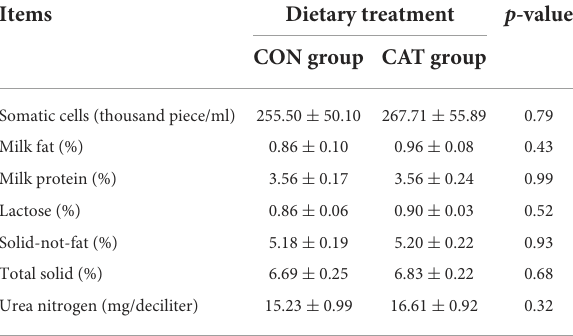
TABLE 4 The effects of maternal dietary CAT supplementation on colostrum nutrient composition. Items Dietary treatment p